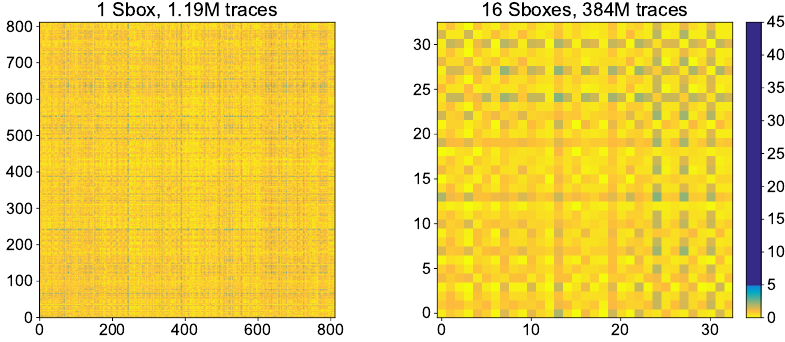
clock cycles per round would change from 16 to 8 for RAMBAM and from 21=5+16 to 13=5+8 for [DMRB18]. For implementations with more Sboxes, the advantage of RAMBAM over [DMRB18] would grow even